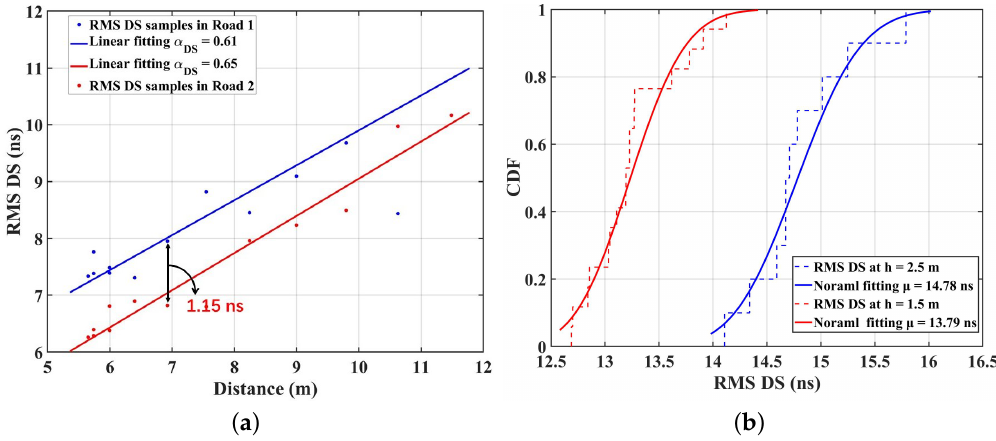
Figure 4. ( a ) The distance dependence of RMS DS samples under single TX case; ( b ) the CDF of RMS DS under the multiple TXs’ case in Road